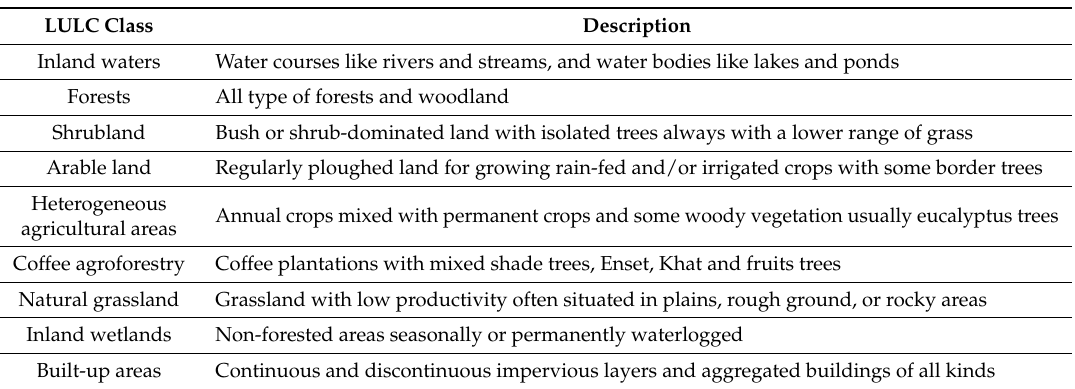
Table 2. Land use and land cover (LULC) classes and their